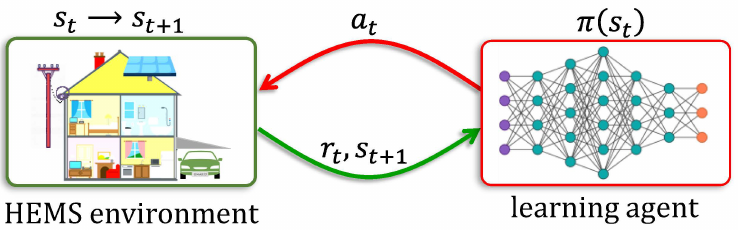
a t , r t → s t + 1 . Although the agent is